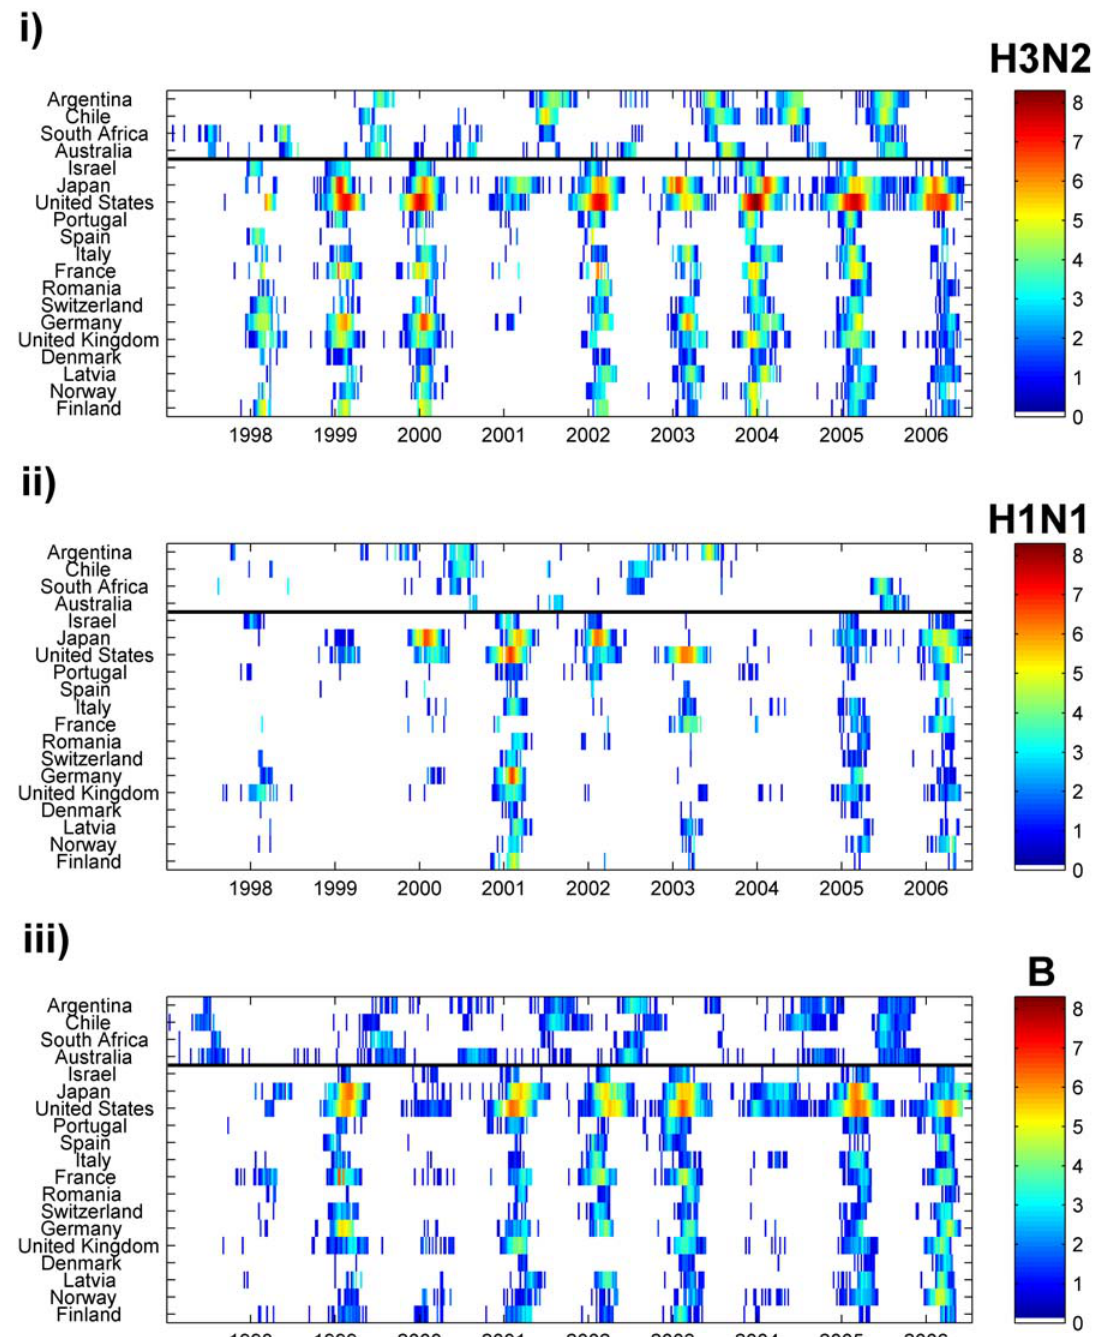
Figure 1. Summary of incidence data. Data on weekly number of isolates by type and subtype were collected from FluNet (WHO) and summarized for 19 countries—arranged from southernmost to northernmost, with the black line dividing the two hemispheres—for influenza seasons from 1997 to 2005. For H3 and H1 subtypes, totals were adjusted to account for type A isolates that were not further subtyped. For all types and subtypes, the adjusted number of weekly isolates was increased by one to remove any zero values. The natural log of the results were plotted by country for (i) H3, (ii) H1, and (iii) B on a color scale, with white representing either zero isolates or no data and brown representing the highest observed number of isolates for H3